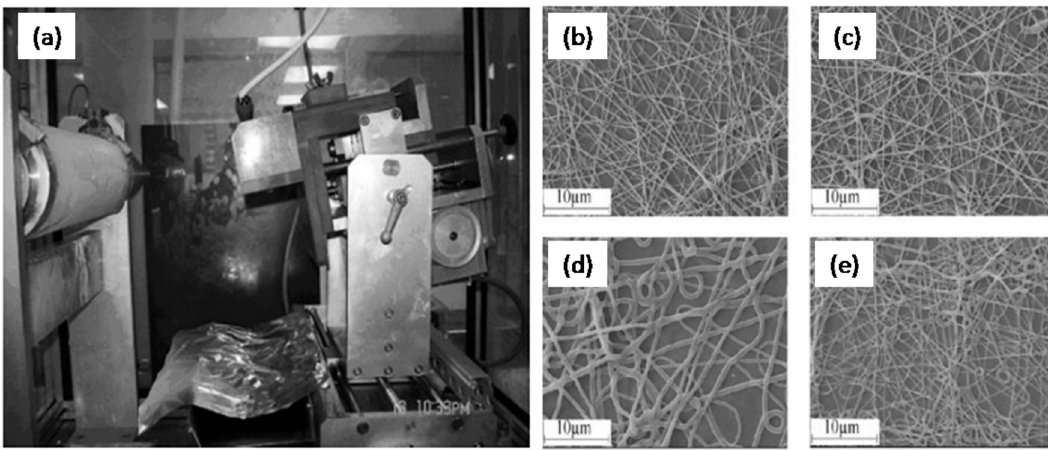
Figure 2. ( a ) Electrospinning setup and SEM images of the nanofibers at different applied